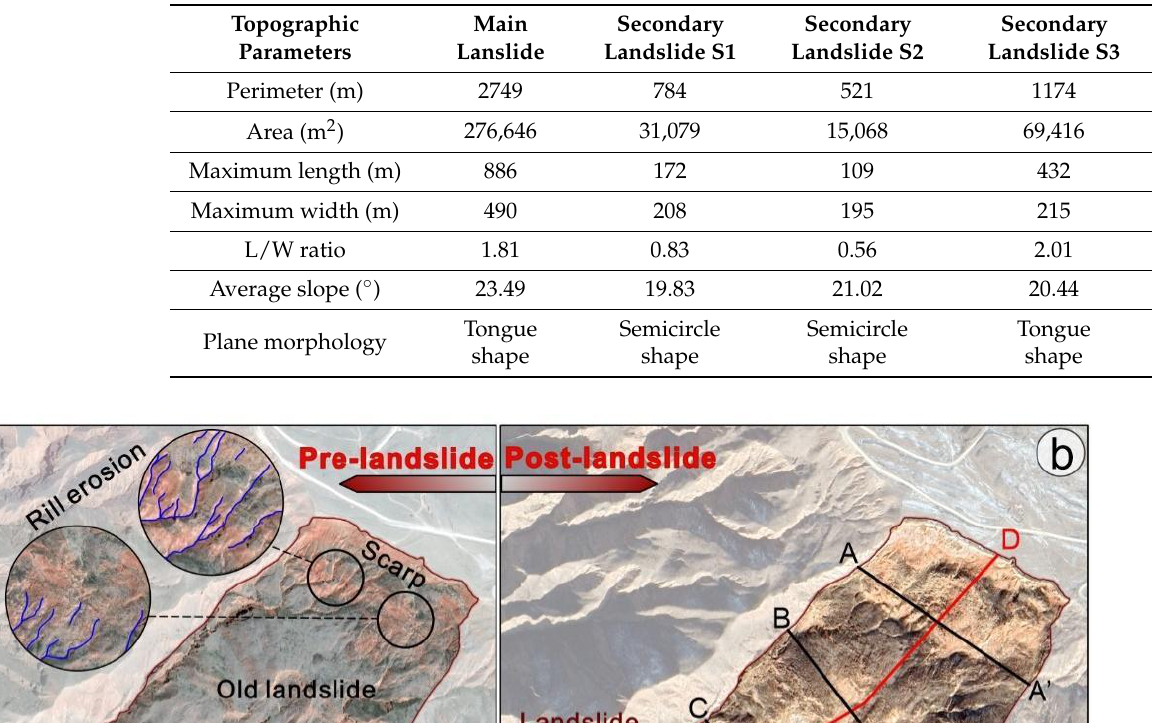
Table 1. Topographic parameters of the main landslide and secondary landslides.